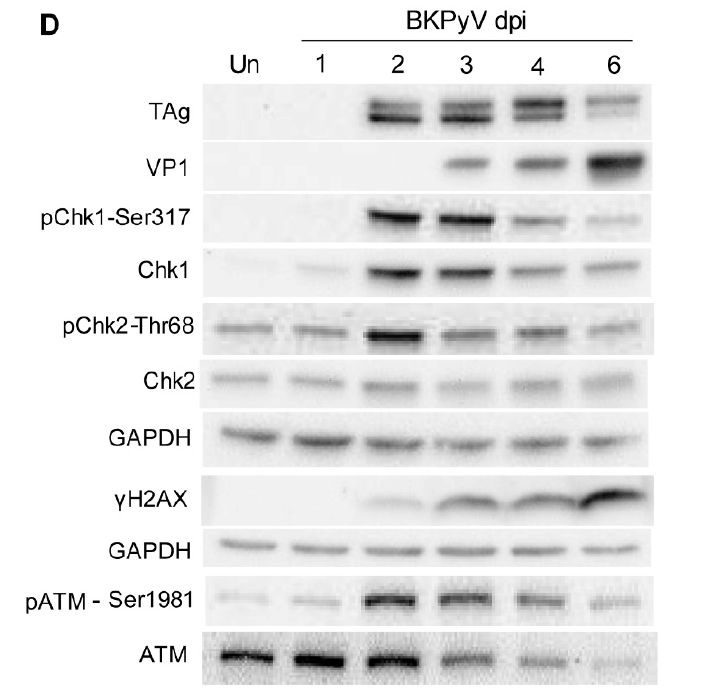
Figure 3. BKPyV infection of RPTECs stimulates a DDR and continued DNA synthesis beyond the normal G2 phase DNA content. Quiescent RPTECs on cover slips were infected with BKPyV Gardner (MOI = 10 IU/cell) and methanol fixed at the indicated days post-infection (dpi); uninfected cells at 0 dpi (Un). ( A ) Cells were stained for TAg (PAb416 and Alexa 448 goat anti-mouse IgG), ( B ) VP1 (PAb597 and Alexa 488 goat anti-mouse IgG) or ( C ) γ H2AX (anti pH2AX-Ser139 and Alexa 488 goat anti-rabbit IgG). All cover slips were treated with RNaseA and stained with propidium iodide prior to mounting. Alexa488 and PI were quantified by laser scanning cytometry. Cell cycle position is color coded as follows: G1 phase (cyan), G2 phase (red) and >G2 phase (blue). Sub-G1 and S phase cells are represented in black. The angled horizontal line indicates the division between positive and negative cell populations. Percentages along right side of plots indicate the percentage of the cell population in gates R5, R4, R7 (moving from top to bottom). ( D ) Whole-cell lysates were prepared from pooled floating and adherent cells by lysing in sample buffer, resolving by SDS PAGE and immunoblotting with the indicated antibodies. Membranes were first probed for phosphoproteins, stripped and then probed with antibody recognizing both phosphorylated and unphosphorylated forms. After incubation with either HRP-conjugated goat anti-mouse or goat anti-rabbit IgG, blots were incubated with SuperSignal West and imaged. TAg, VP1, Chk1, Chk2 and the upper GAPDH were analyzed on the same 4–20% gel; γ H2AX and the lower GAPDH on an AnyKD gel; ATM on a 3–8% gel. The change in the ratio of the doublet bands of TAg (large T) between 3 and 4 dpi was not consistently observed; representative blot of n = 3.